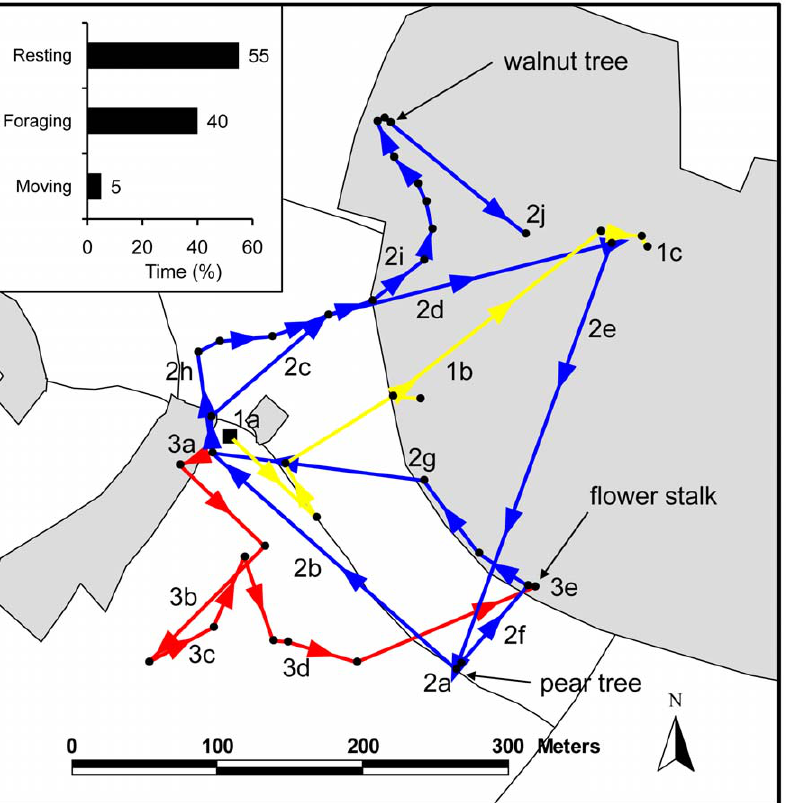
Figure 5. Detailed movement trajectories of one Bombushortorum individual (bee 1, see Table 1) followed over a time period of . 12 hours (within 2 days) with 3 continuous tracking periods. Trajectory 1 (yellow line, order from 1a to 1c) is the first tracking period from 1–3:45 pm (165 min), starting from the study site (black square) after transmitter attachment on the first day (June-30). Trajectory 2 (blue line, from 2a to 2j) is the second tracking period from 8:45 am to 2:55 pm (370 min) on the following day (July-1), and trajectory 3 (red line, from 3a to 3e) is the third tracking period in the afternoon of the same day from 4:25–7:50 pm (205 min). The inset shows the percentages of total time spend for three different behavioral categories (resting, foraging, and moving). Note that the bumblebee rested for long time periods ( . 45 min) on a pear tree (105 + 80 min), a walnut tree (95 min), and a flower stalk (60 min + subsequent overnight stay). Flight times between points were rather short (usually , 1